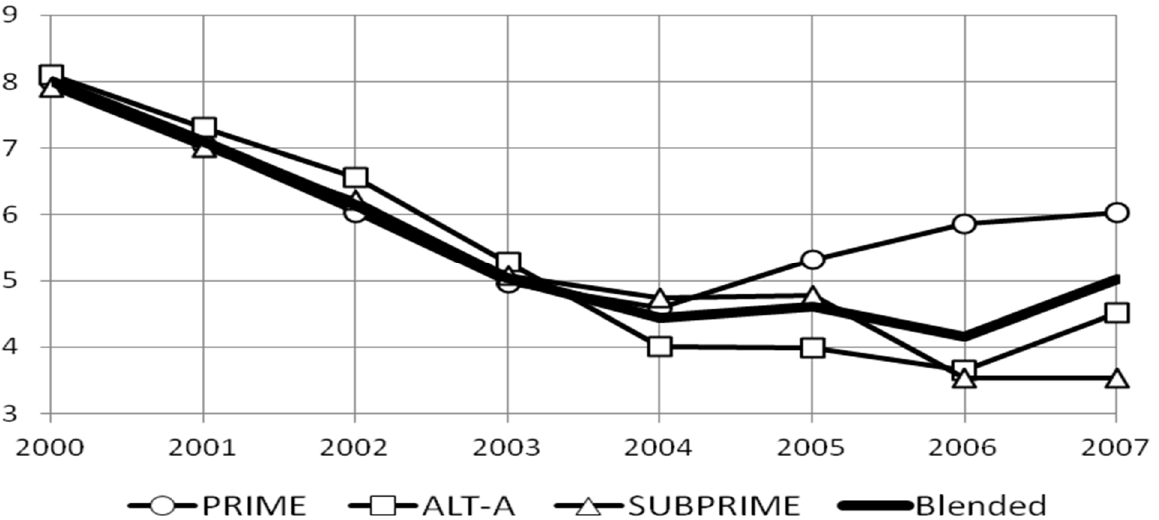
Figure 4. Subprime Mortgage Originations. Table 1 illustrates the effects of the new stringent underwriting requirements intro- duced by Dodd–Frank legislation. Home mortgages have become more difficult to obtain resulting in a drastic decrease in mortgage availability. In the 2004–2006 period, there were no down payment requirements, no need for income verification, no debt-to-income ratio requirements and an influx to adjustable-rate mortgages due to the attractive initial “teaser rates”. Today, the no down payment opportunity does not exist, proof of income for a two year-period is required and the most stringent test is the debt-to-income celling